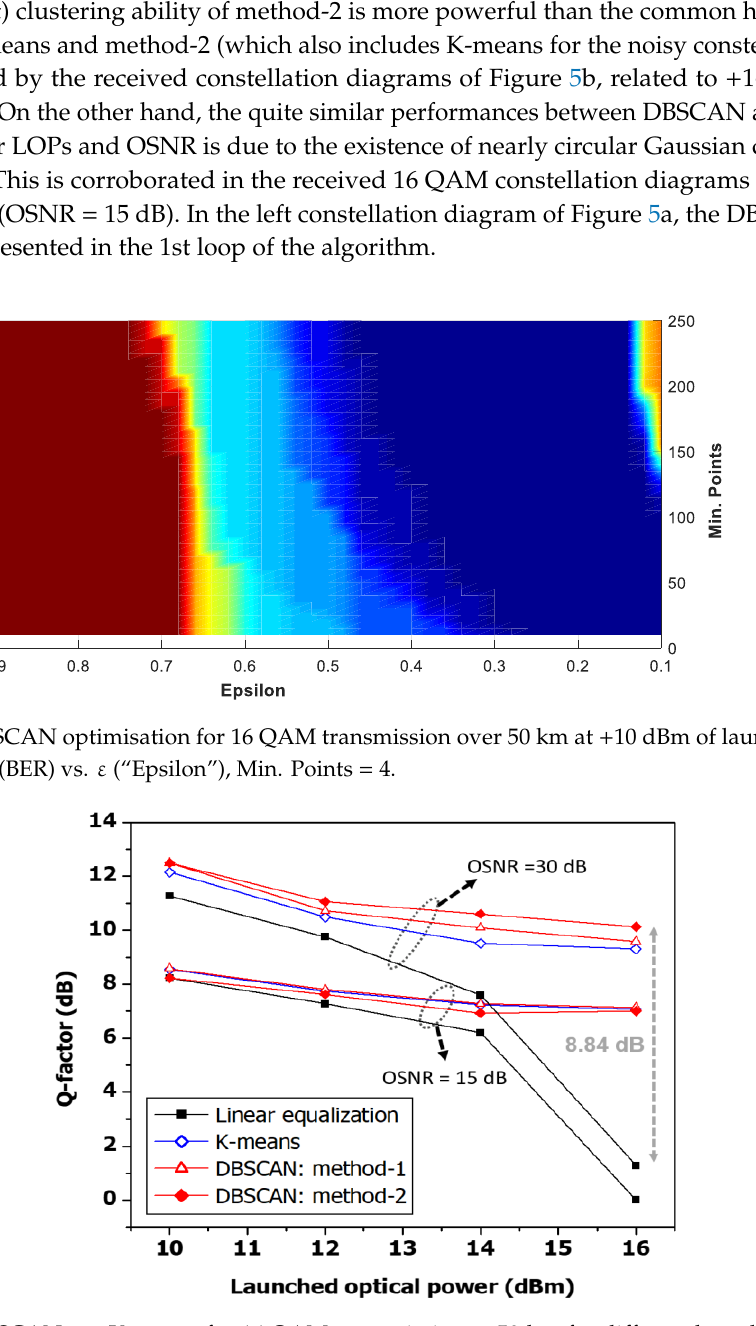
Figure 4. DBSCAN vs. K-means for 16 QAM transmission at 50 km for different launched optical powers (LOPs) when optical signal-to-noise ratio (OSNR) is 30, 15 dB.